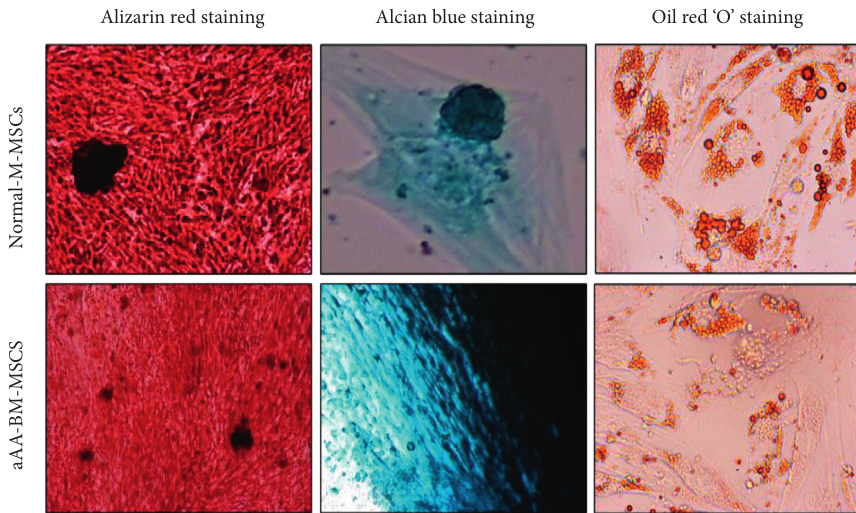
Figure 4: Representative images for trilineage differentiation of BM-MSCs from normal and aAA patients. Alizarin red staining represents the mineralization and signifies the osteogenic differentiation. Alcian blue staining represents the chondrocytes differentiation whereas oil red “O” staining represents the differentiation to adipocytes. Upper panel: normal BM-MSCs. Lower panel: aAA BM-MSCs.